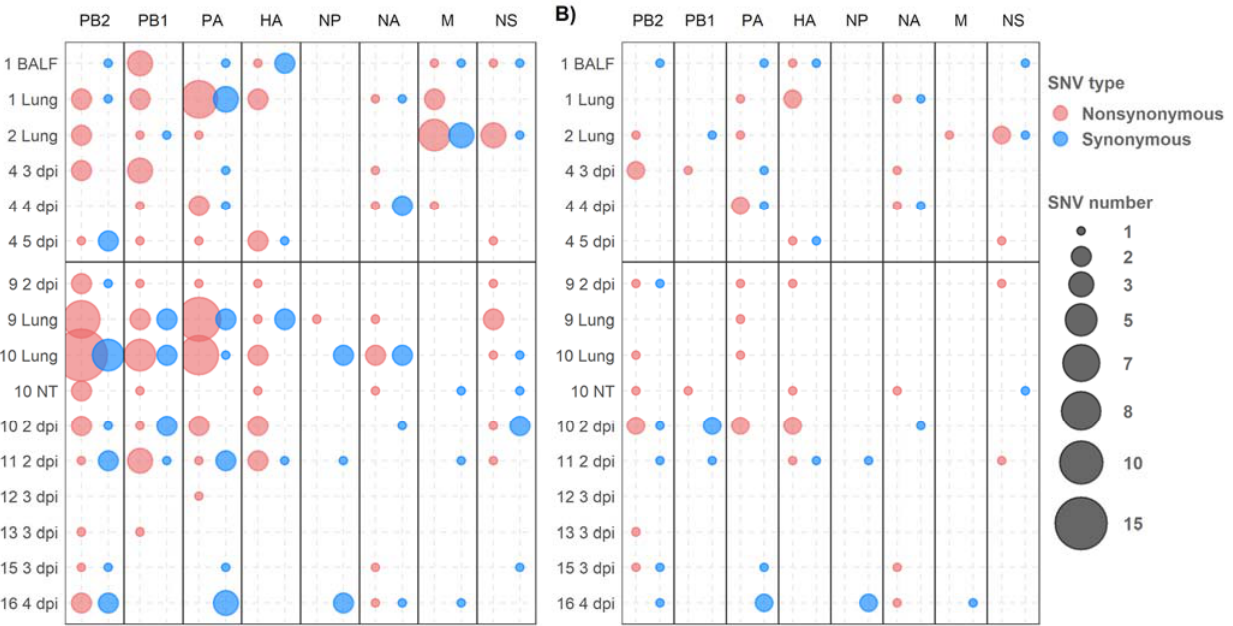
Figure 6. Proportion of synonymous and nonsynonymous de novo SNVs generated in sequences collected from vaccinated and nonvaccinated pigs. Substitutions with an allele frequency greater than 1% ( a ), 2.5% ( b ), 5%( c ), 7.5% ( d ), and 10% ( e ) are represented.